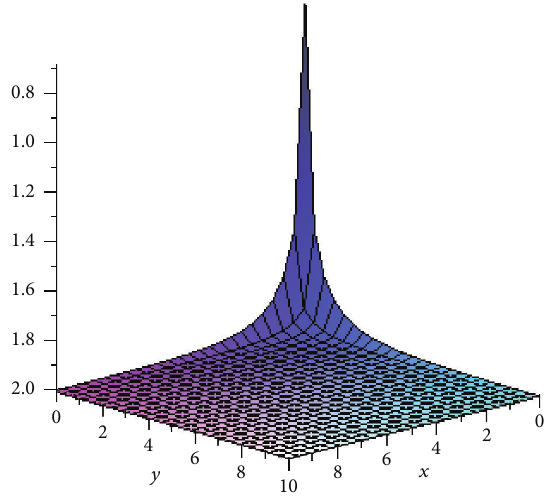
Figure 2: The solitary wave solution V 1 with 𝑒 1 = 1 , 𝑎 = 𝑏 = 𝑐 = 𝑘 = 1 = 1 , 𝑡 = 0.1 , and 𝛼 = 1/2